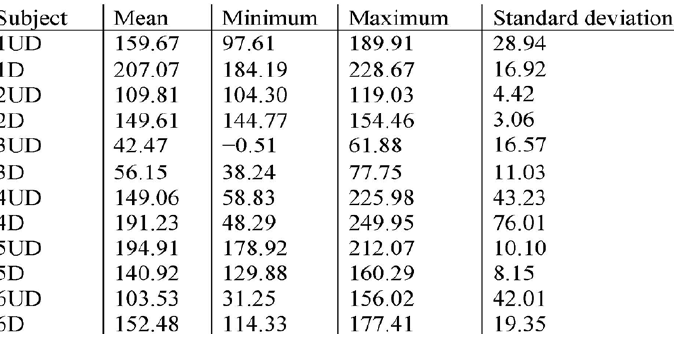
Table 2: The mean B implicit time, minimum, maximum and 1 standard deviation of ten recordings for each eye of each subject